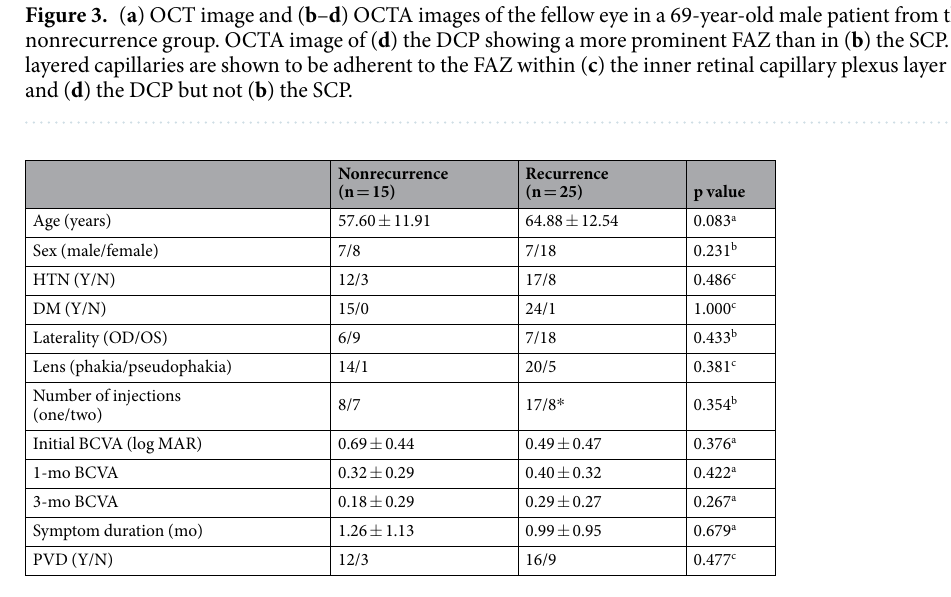
Table 2. Patient characteristics. BCVA = best-corrected visual acuity; DM = diabetes mellitus; HTN = hypertension; mo = month; PVD = posterior vitreous detachment. * Number of injections in the recurrence group was the number of injections before recurrence within 6 months after ME resolution following treatments. a Mann-Whitney U test. b Pearson chi-square test. c Fisher’s exact